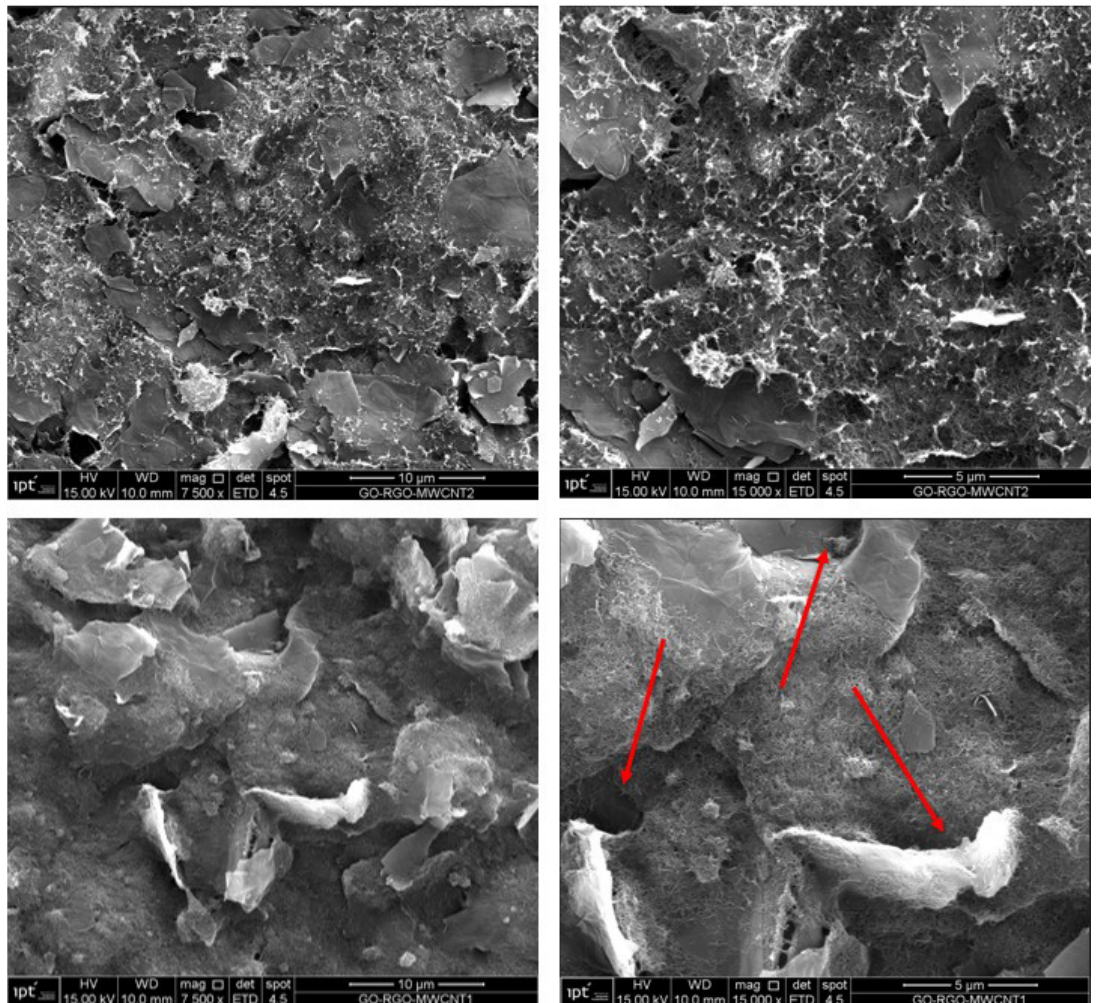
Figure 5. Hybrid paper-like SEM images untreated ( a-b ) and treated ( c-d ) thermally. Red arrows in ( d ) indicate gas voids regions caused by thermal annealing.